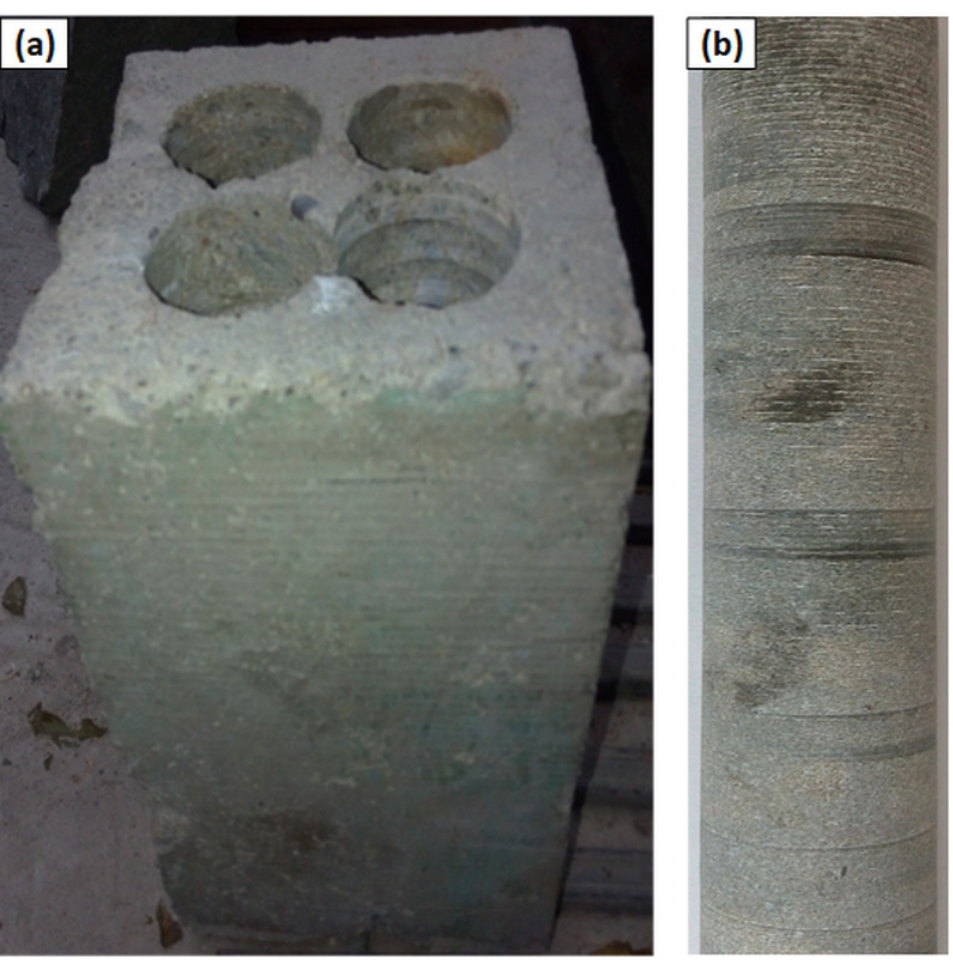
Figure 4. Result of practical drilling in laboratory conditions (( a ) block-shaped rock sample with boreholes, ( b ) drilling rock